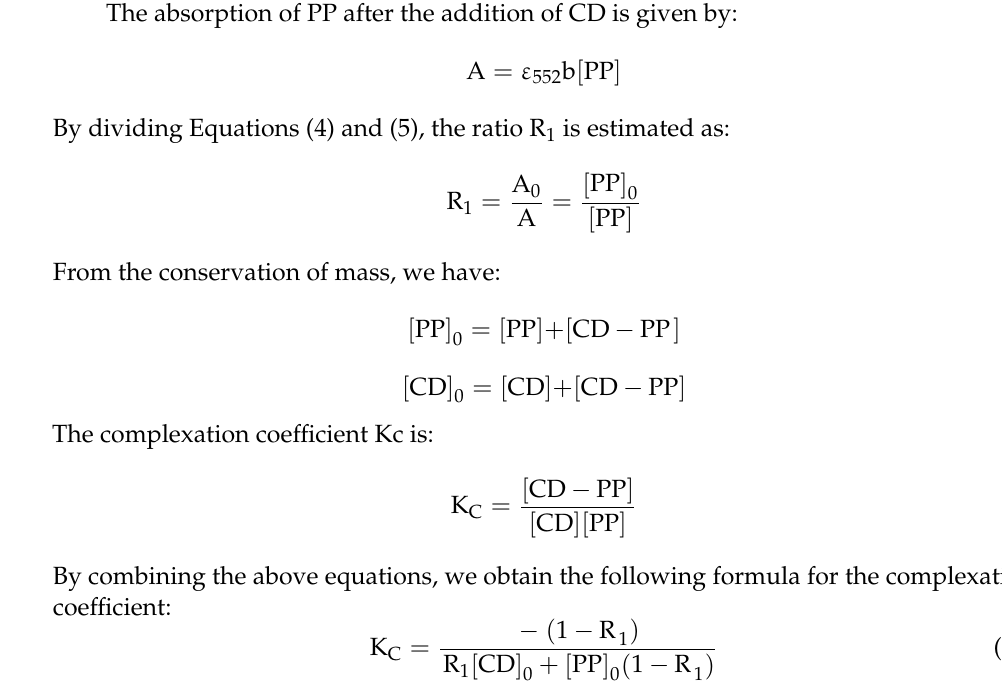
where b is the optical path length, ε 552 is the molar attenuation coefficient or absorptivity of the attenuating species at the 552 nm wavelength and [PP] 0 is the is the concentration of the pure PP.